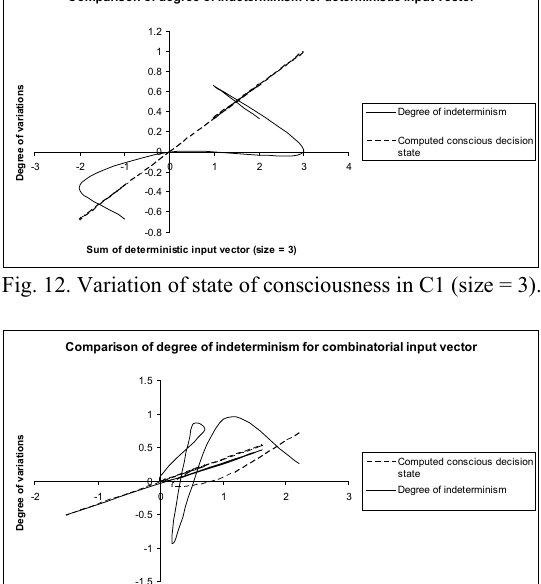
Fig. 11. Variation of state of consciousness in C2 (size = 2). Comparison of degree of indeterminism for deterministic input vector